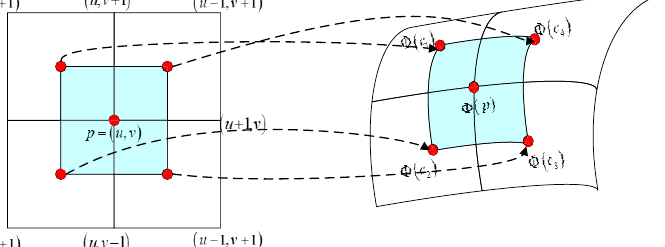
Figure 2. The structure and transformation process of 